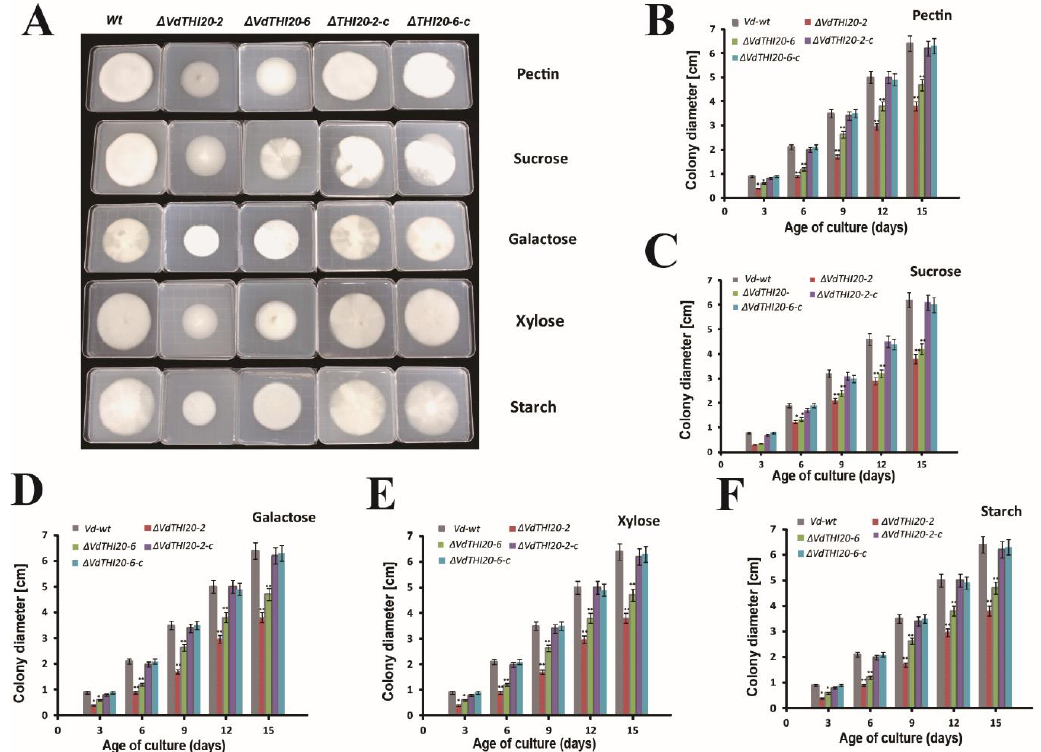
Figure 3. Mycelial growth of the Vd-wt strain, ΔVdTHI20 ( ΔVdTHI20-2 and ΔVdTHI20-6 ) mutant strains, and complemented strains ( ΔVdTHI20-2-c and ΔVdTHI20-6-c ). ( A ) Colony morphology was observed on MM agar with different carbon sources after 15 days. ( B – F ) Colony diameters of Vd-wt strain, ΔVdTHI20 mutant strains and complemented strains grown on different carbon sources, sucrose, pectin, starch, galactose, and xylose, respectively. Colony diameters were measured after 3, 6, 9, 12, and 15 days. Values represent the mean ± standard deviation from three independent replicates. Mycelial growth of the ΔVdTHI20 mutant strains and the complemented strains on MM agar were compared with Vd-wt strain. Asterisks (*) indicate significant differences by Student’s t test at P < 0.05. Asterisks (**) indicate significant differences by Student’s t test at P < 0.01.